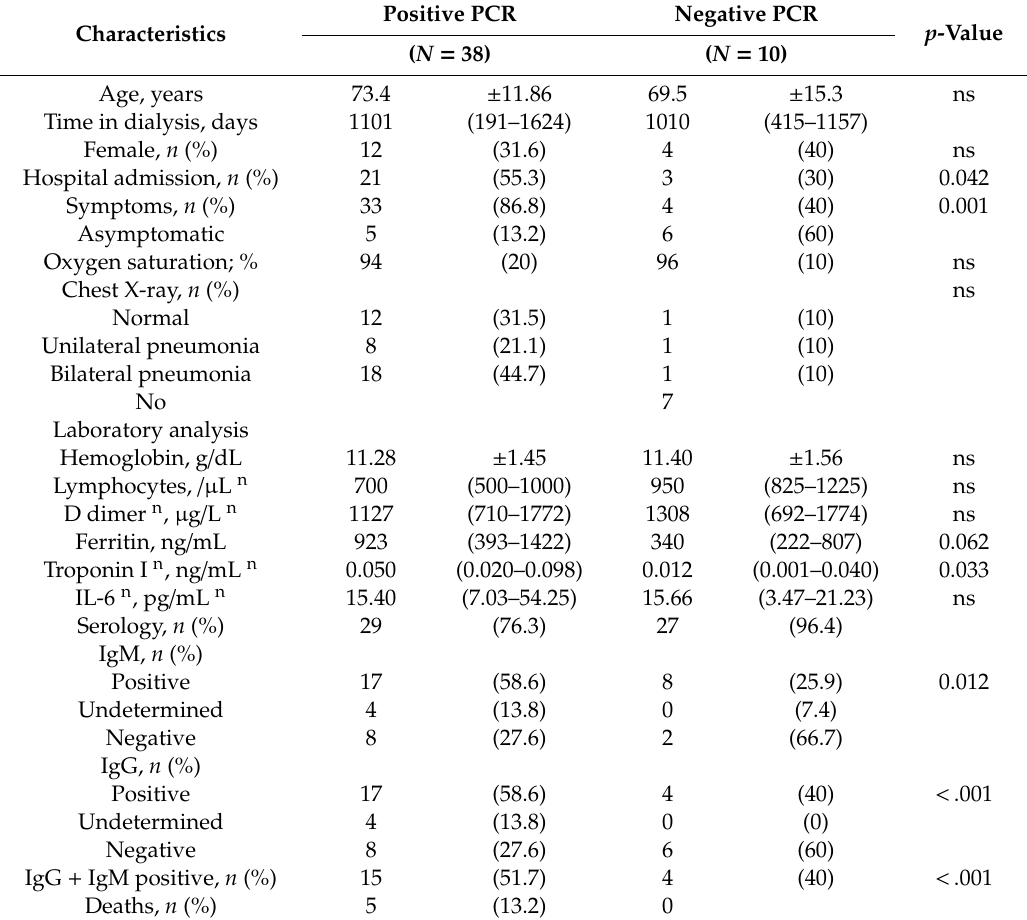
Table 1. Characteristics of patients with positive and negative polymerase chain reaction (PCR). Data presented as mean ± SD, median (interquartile range) or counts